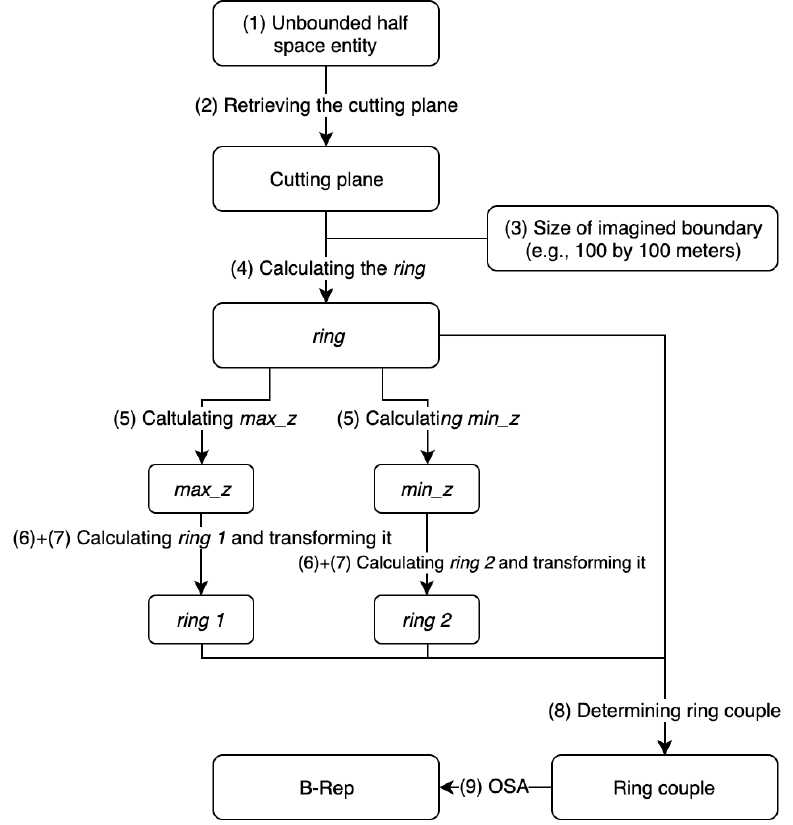
Figure 6. Steps for instantiating unbounded half space entities.